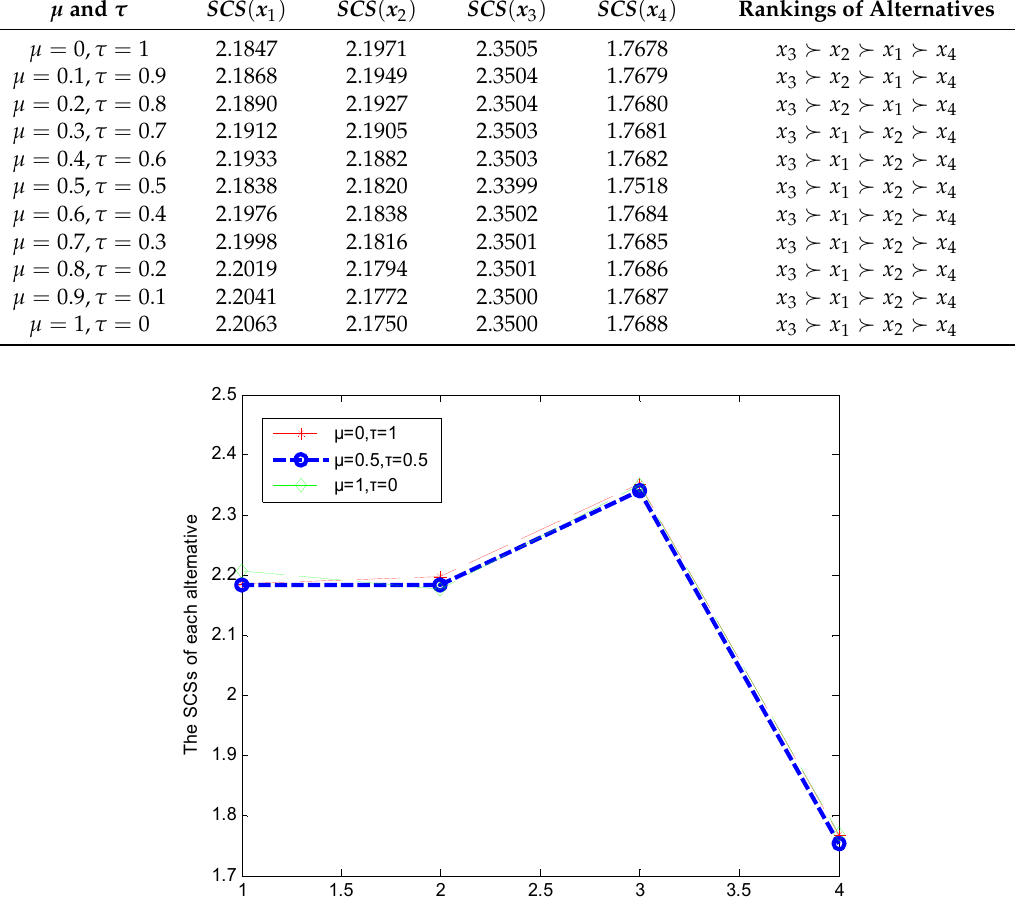
Table 5. Rankings of the alternatives with different values of µ and τ .